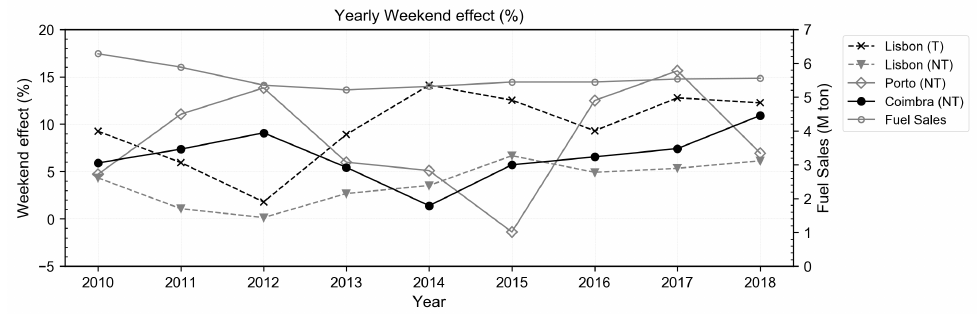
Figure 17. Yearly average Weekend effect (%) for all